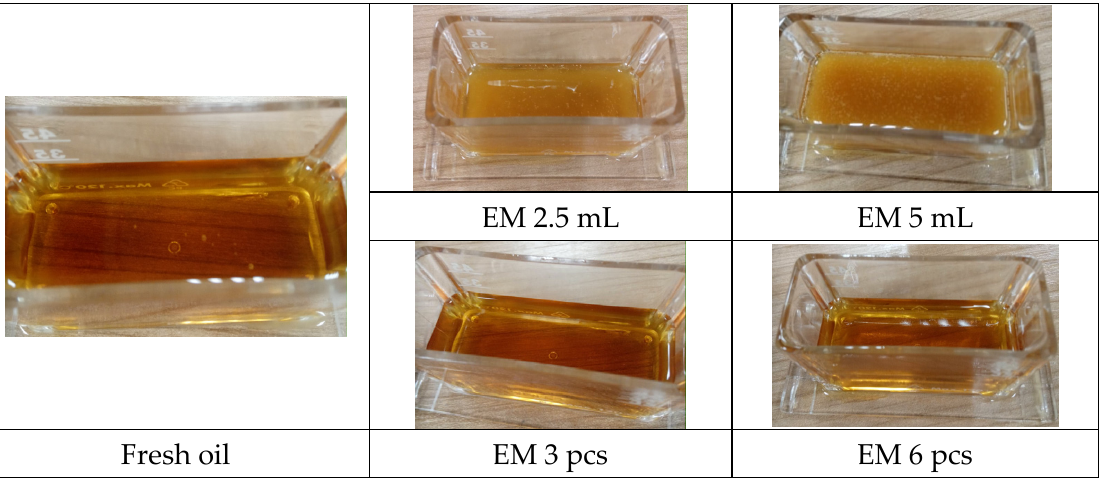
Figure 5. Coloring of fresh oil, with the addition of effective microorganisms in liquid form and ceramic tube form.